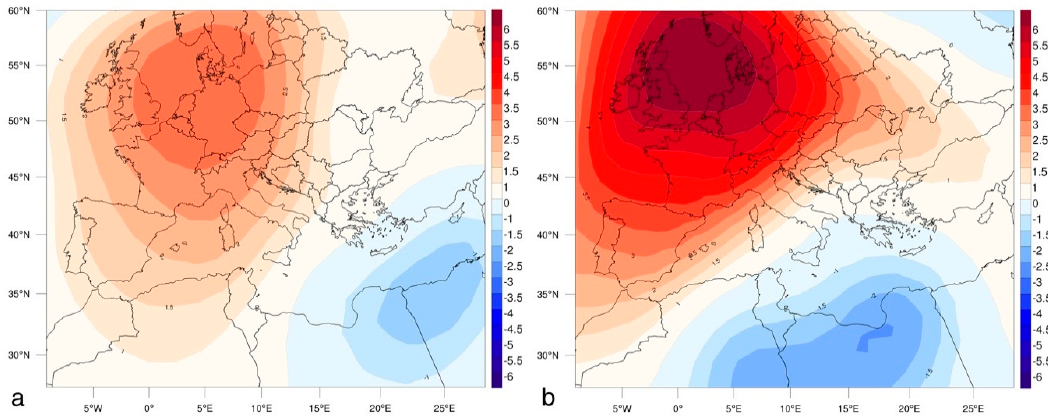
Figure 10. Standardized 500-hPa geopotential height anomaly (dimensionless) of daily values compared to 30-year climatology for ( a ) 14 February 2019 and ( b ) 25 February 2019.